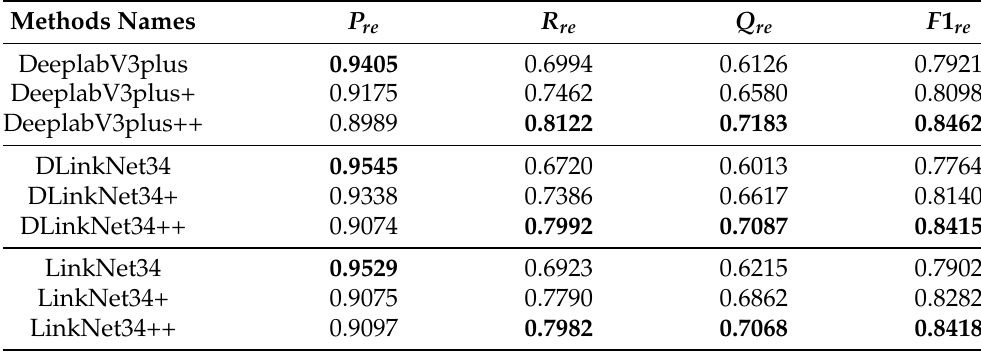
Table 6. Comparative quantitative Evaluation Among Different Methods for Road Extraction on our dataset. With the best results marked in bold. α = 1, β =